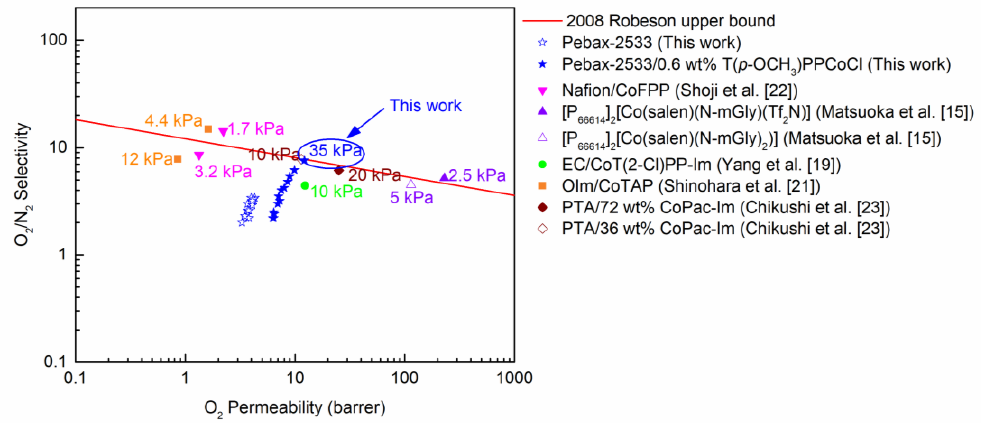
Figure 8. Performance comparison with the Robeson upper bound. Table 1. Comparison of the separation performance of the reported membranes with this work.